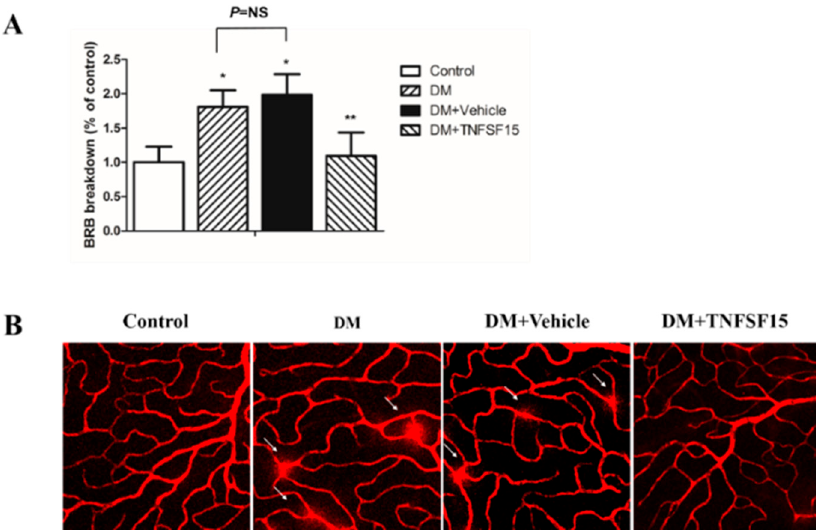
Figure 4. The protective effect of TNFSF15 on diabetes induced BRB permeability. ( A ) Quantitative measurement of the BRB permeability by quantification of extravasated EB. Data are presented as percentage of controls (six eyes). * p < 0.001, compared with the control group; ** p < 0.001, compared with the DM group; NS = nonsignificance; ( B ) Representative images showing EB fluorescence. In the retina of control rats, EB fluorescence is limited to the blood vessels, whereas in diabetic retina, the dye leaks out of the vessels to the retinal tissue (arrows). TNFSF15 treatment prevents the leakage of EB. Magnification 400×.